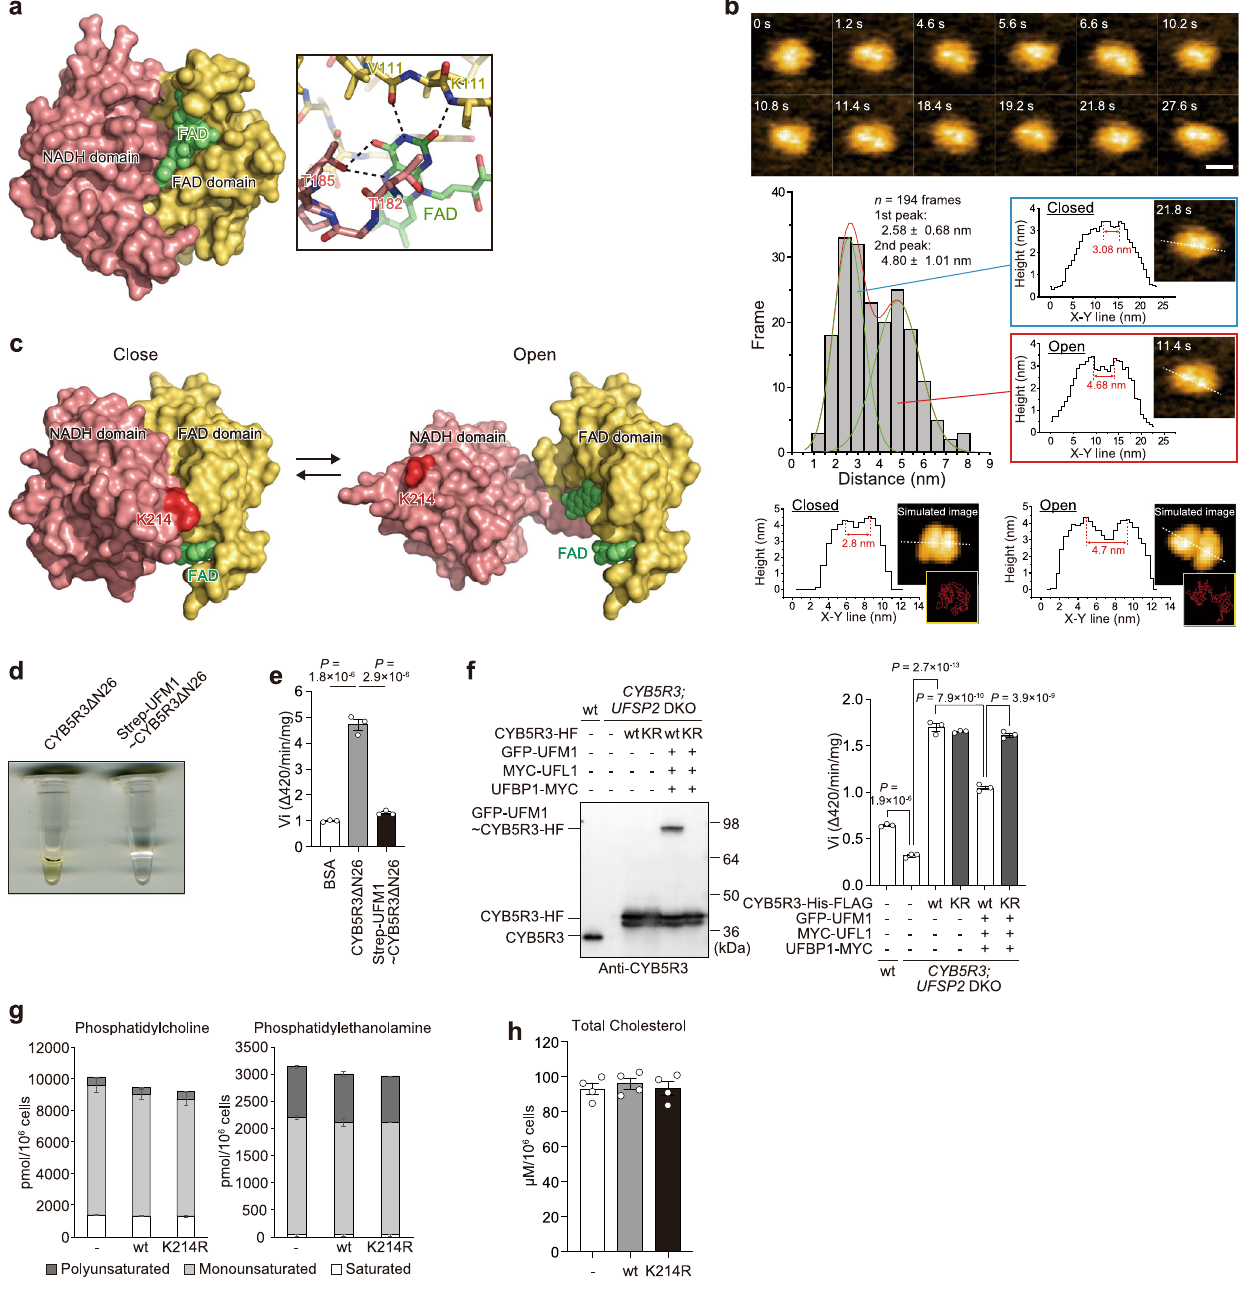
Fig. 3 | Loss of CYB5R3 enzymatic activity after ufmylation. a Left, crystal structure of human CYB5R3 (PDB 1UMK). FAD and NADH domains are colored yellow and salmon pink, respectively, whereas bound FAD is colored green. Right, close-up view of the domain interface that recognizes FAD. Broken lines indicate possible hydrogen bonds. b Top, Successive HS-AFM images of CYB5R3. Scale, 10nm; Height, 0 – 4nm. Middle, Histograms of the distances between two globular lobes from 194 frames of 1 molecule. Representative images of closed and open conformations with height pro fi les are shown right. Bottom, Height pro fi les of simulated AFM images from the crystal structure (PDB ID: 1UMK) (left) and the manually arranged structure (right) with the simulated images. c The closed conformation (left) corresponds to the crystal structure (1UMK) while the open conformation (right) was manually prepared based on the HS-AFM data. CYB5R3and FAD are shown withsurface and space- fi lling models, respectively. d Color comparison of puri fi ed free CYB5R3 with ufmylated CYB5R3. Recombinant CYB5R3 and UFM1-conjugated CYB5R3 were